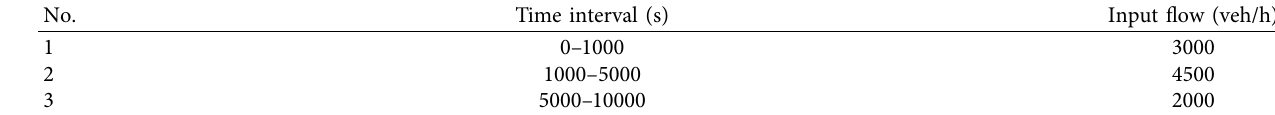
Table 4: Simulation parameter input.